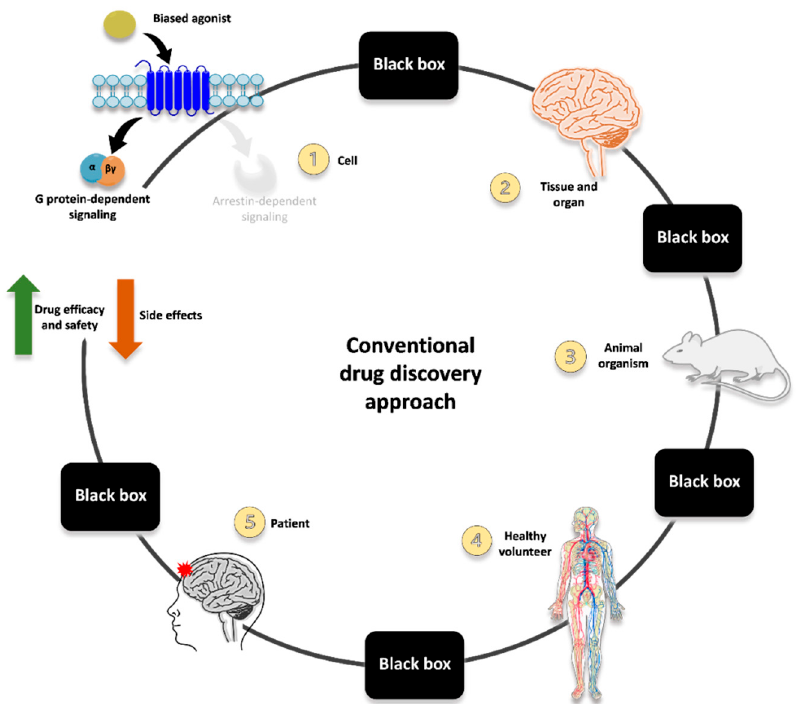
Figure 1. Schematic representation of the conventional approach to developing G protein-biased opioid agonists. One of the main challenges in contemporary medicinal chemistry is the develop- ment of safer and more effective analgesics for pain treatment. In the conventional drug discovery approach, the first goal for the development of biased ligands is the identification of agonists exert- ing their effects through functionally selective mechanisms and the association of these mechanisms with a desired in vitro cellular response ( 1 ). While G proteins and arrestins are undoubtedly critical signaling effectors that regulate both normal and abnormal physiology, attributing the complex GPCR signaling to proximal transducers is too reductive. Frequently, the signaling pathways di- rectly responsible for the therapeutic and detrimental side effects are largely considered a black box because they are not thoroughly predictable and understandable. This is due to a lack of knowledge at the whole system level, which integrates multiple effectors and interdependent networks. Fur- thermore, the drug behavior is influenced by its exposure at the site of action in tissue/organ ( 2 ), which may be difficult or impossible to measure experimentally. Due to the many differences in physiological systems upon measuring bias, the translation from in vitro profiles of biased signaling into in vivo animal models ( 3 ) represents the major complication in the search for safer bias. The complexity of this scenario is profoundly incremented by the variability in drug response at the healthy volunteer ( 4 ) and patient ( 5 ) levels, which arises from differences in the proteome, genome, disease states, lifestyle, and history. Innovative ligands are typically screened for their ability to induce G protein activa- tion and arrestin recruitment at the receptor (often employing one assay type per each of the two readouts; thus, not including multiple levels of possible functional selectivity and interplay between different signaling pathways). Then, hallmarks of G protein-dependent or arrestin-mediated signaling are evaluated in in vitro/ex vivo tissue preparation to cor- roborate the functional selectivity of the ligands (e.g., differential MAPK activation and production of second messengers and mediators). After that, the most promising candi- date is evaluated in pre-clinical models recapitulating some behaviors/responses related to therapeutic and adverse effects (e.g., antinociception vs. constipation, respiratory de- pression, sedation). Once the in vitro and pre-clinical evidence is consistent and robust enough, studies can be carried out in humans, first in healthy subjects and then in specific patient categories.